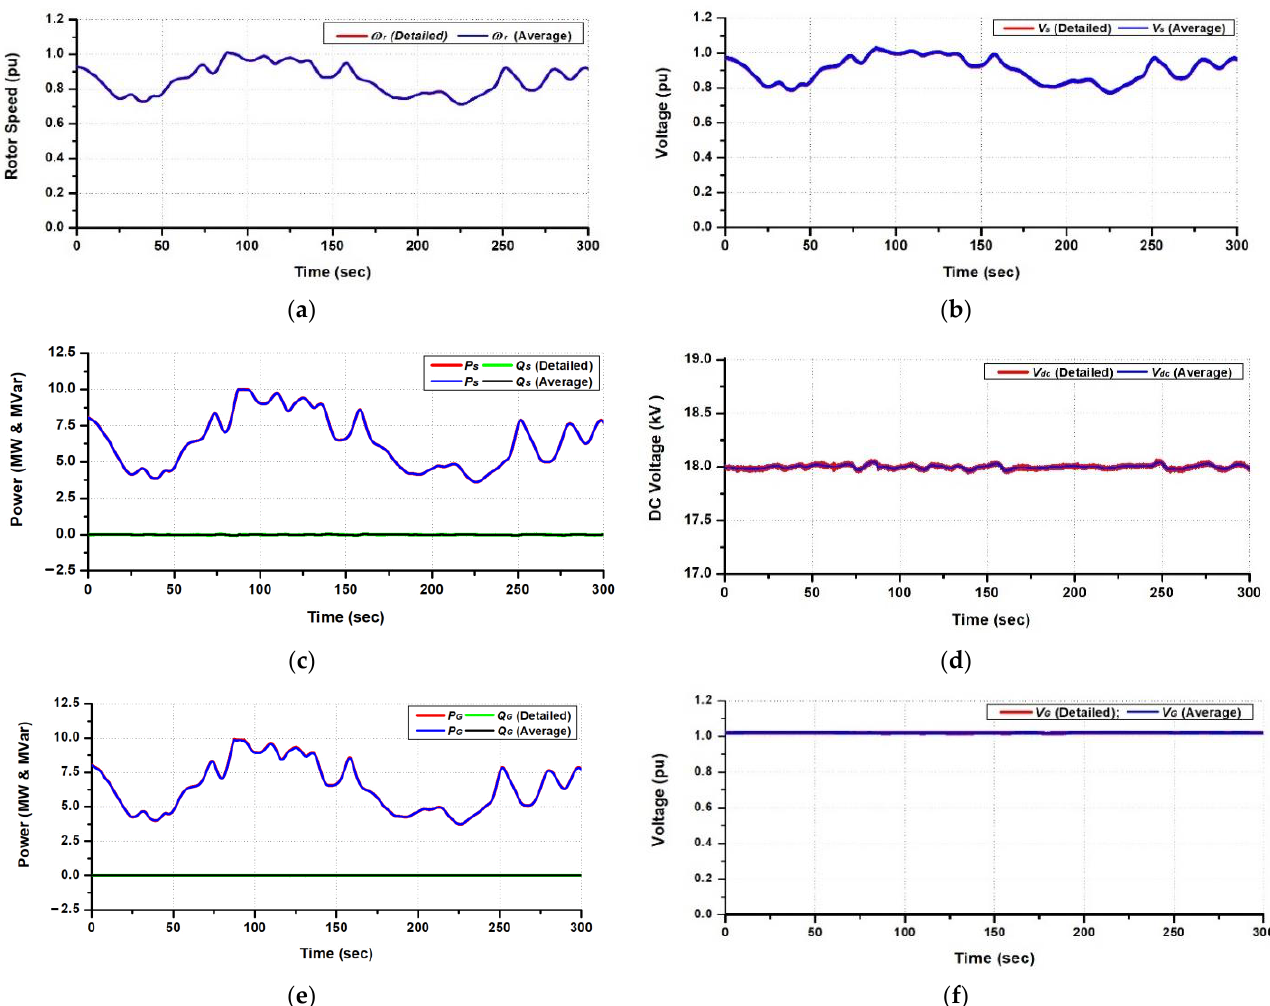
Figure 19. Dynamic Performances of WTG1 under steady-state condition: ( a ) Rotor speed response; ( b ) Voltage profiles at the terminal of the stator winding; ( c ) Active and reactive power output of the PMSG; ( d ) DC link circuit voltage profile; ( e ) Active and reactive power output of grid-side MMC; ( f ) Voltage profile at Bus BG1.